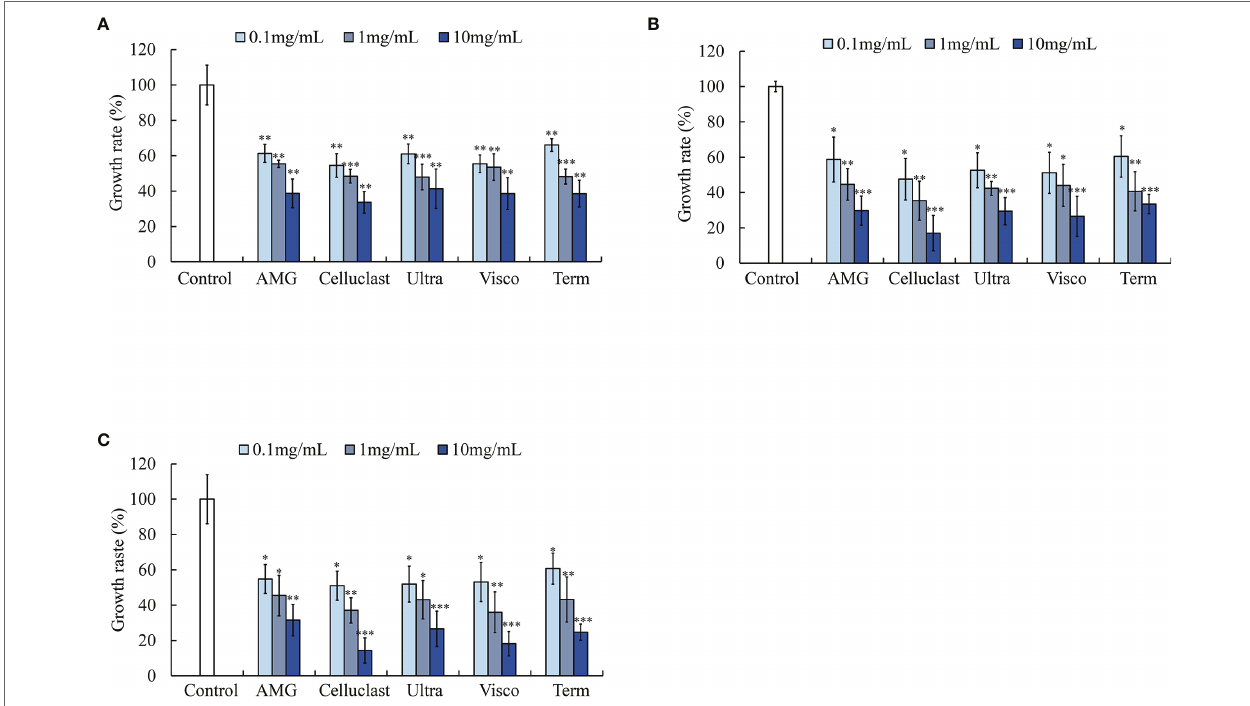
FIGURE 2 | Effect of various enzymatic extracts of SH on pathogenic bacterial growth (A) S. parauberis , (B) E. tarda and (C) S. iniae growth. Experiment was triplicated and statistical evaluation was done to compare the experimental and control groups. Values are significantly different from the control group at *p<0.05, **p<0.01, and ***p<0.005 (AMG: S. horneri AMG enzymatic extract; Celluclast: S. horneri Celluclast extract; Ultra: S. horneri Ultraflo enzymatic extract; Visco: S. horneri Viscozyme enzymatic extract and Term: S. horneri Termamyl enzymatic extract). The samples were treated to the bacterial culture at different concentrations as 0.1,1 and 10